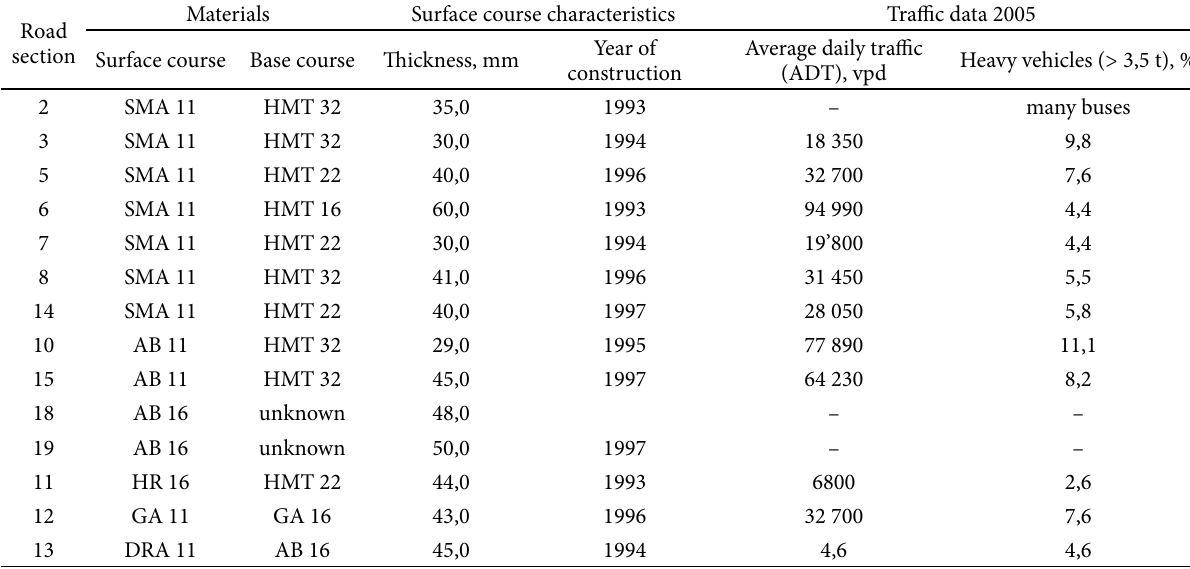
Table 1. Coring sites with pavement characteristics and traffic data (Bundesamt für Straßen ASTRA; Bundesamt für Statistik BFS 2006) Road